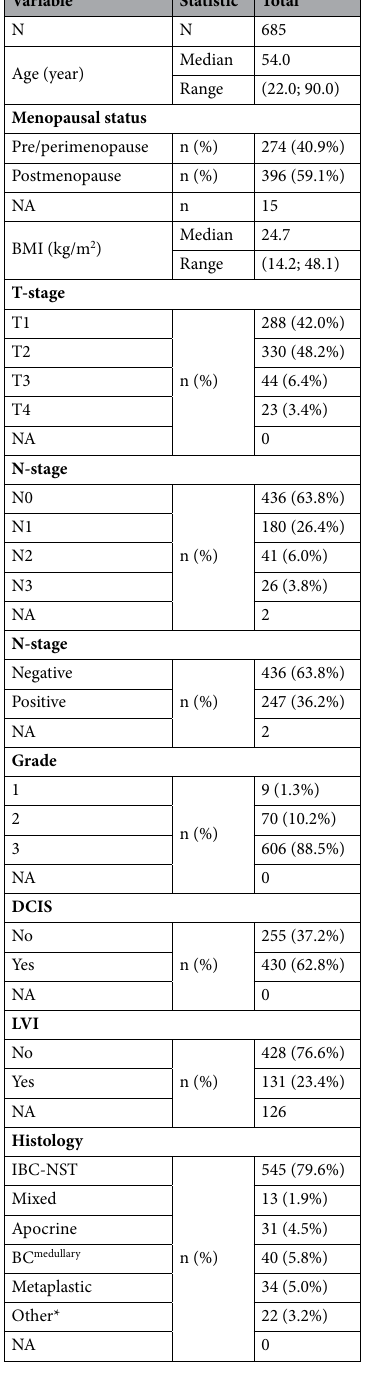
Table 1. Baseline patient- and tumor characteristics for all patients. NA not available, CT chemotherapy, DCIS ductal carcinoma in situ, LVI lymphovascular invasion, IBC-NST invasive breast carcinoma of no special